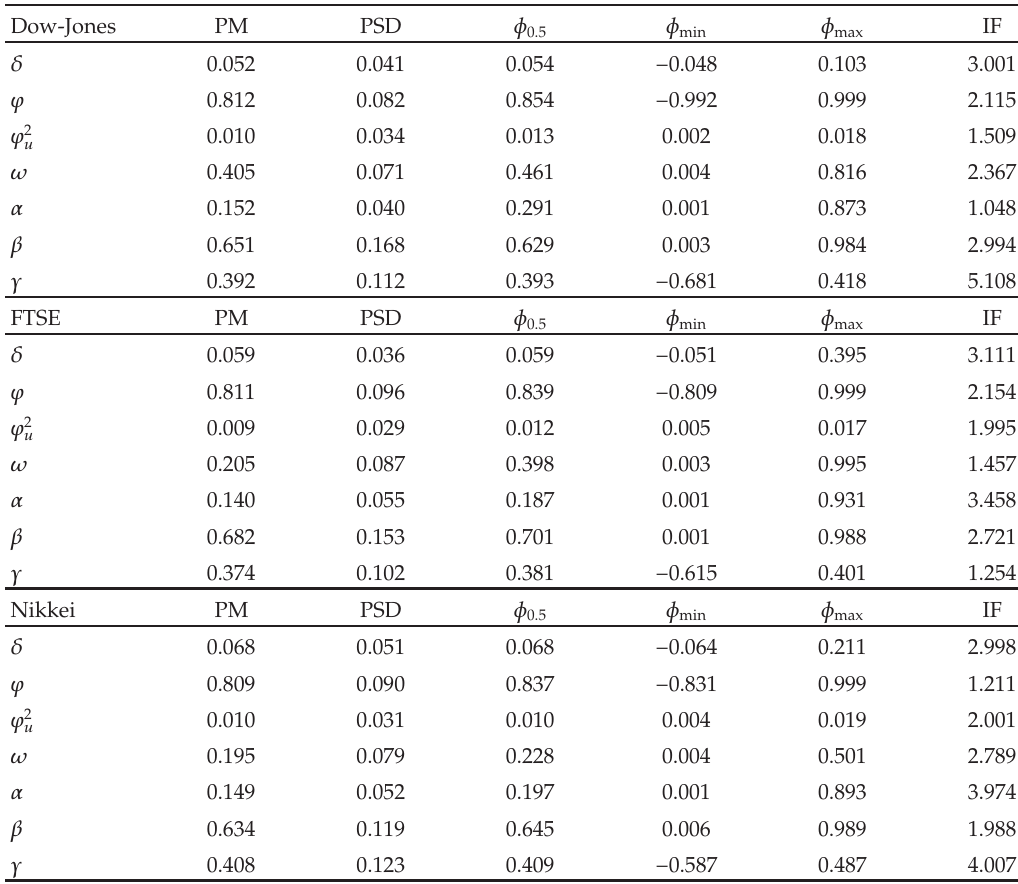
Table 2: Bayesian inference